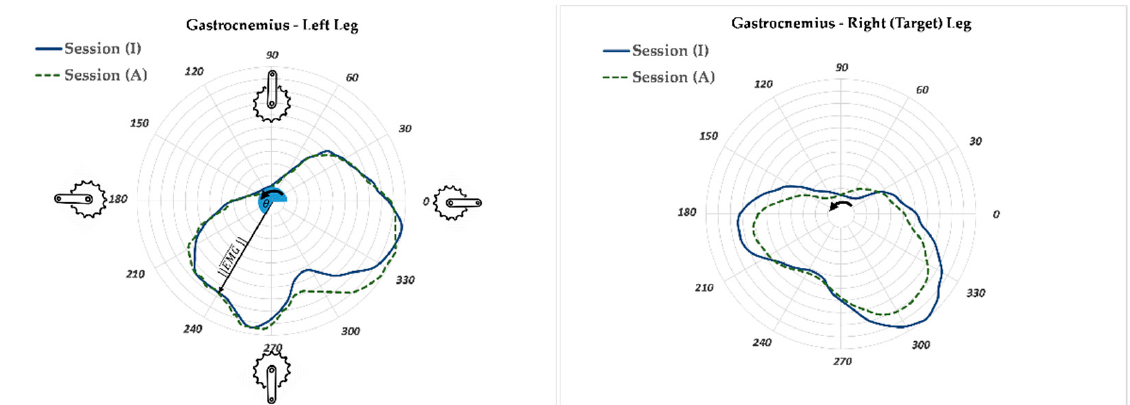
Figure 8. The Polar plot of gastrocnemius muscle activity of left and right legs for Trial 2 (60 RPM). The GM was active mostly when the crank angle varied from 180–360° (±30° SD). The gastrocnemius muscle activity was reduced when APAD was active for the target leg (right leg). The radius (cid:4698)(cid:3627) 𝐸𝑀𝐺 (cid:3627)(cid:4698) , and angle 𝜃 represent the magnitude of normalized EMG and the crank angle, respectively. The arrow shows the direction of rotation.